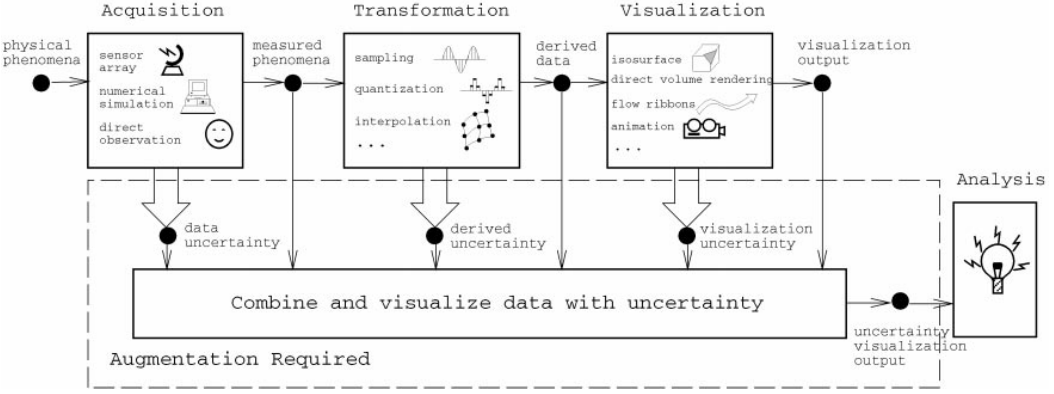
Figure 2. Sources of uncertainty in the data analysis pipeline